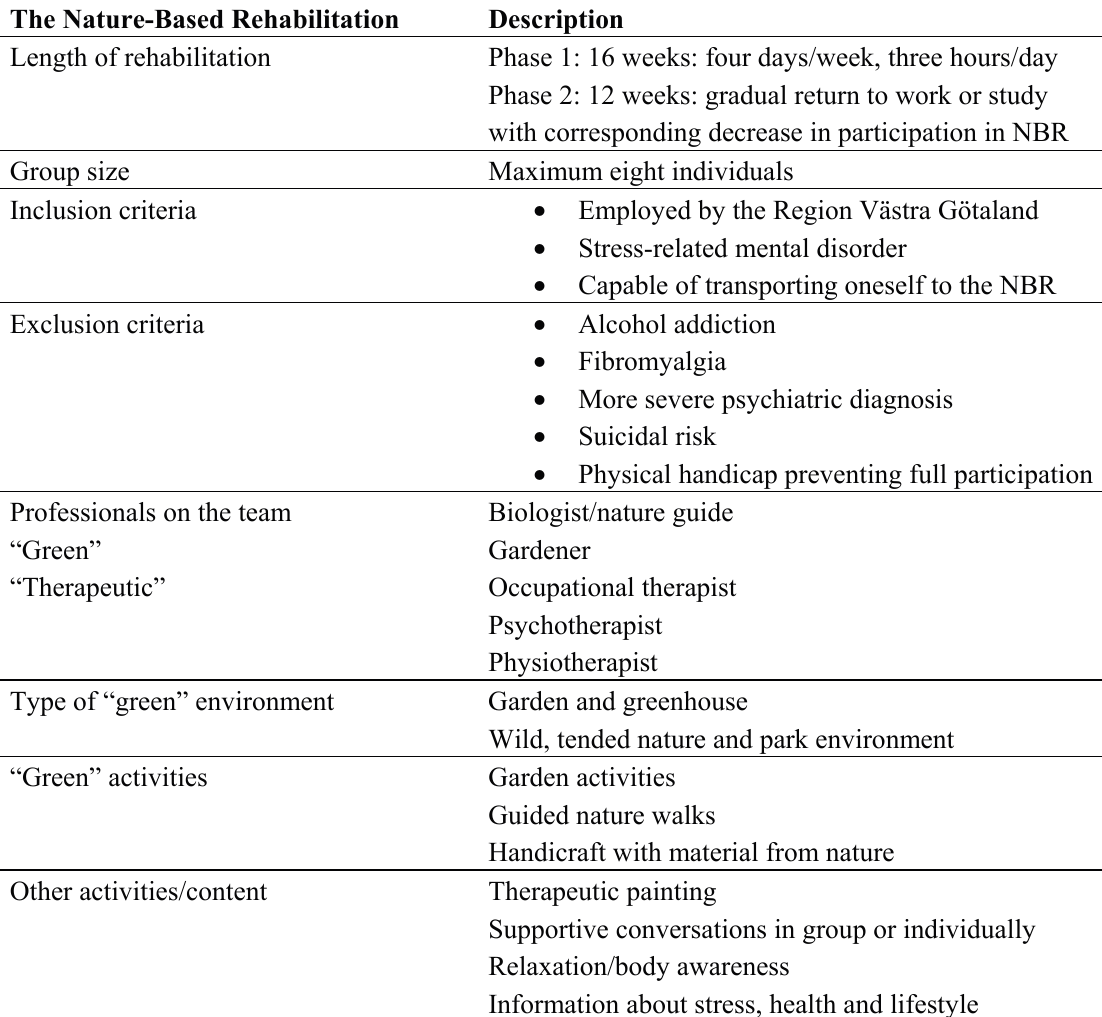
Table 1. Description of the Nature-Based Rehabilitation with respect to rehabilitation time, group size, inclusion and exclusion criteria, professionals on the team, types of environment, and activities within the